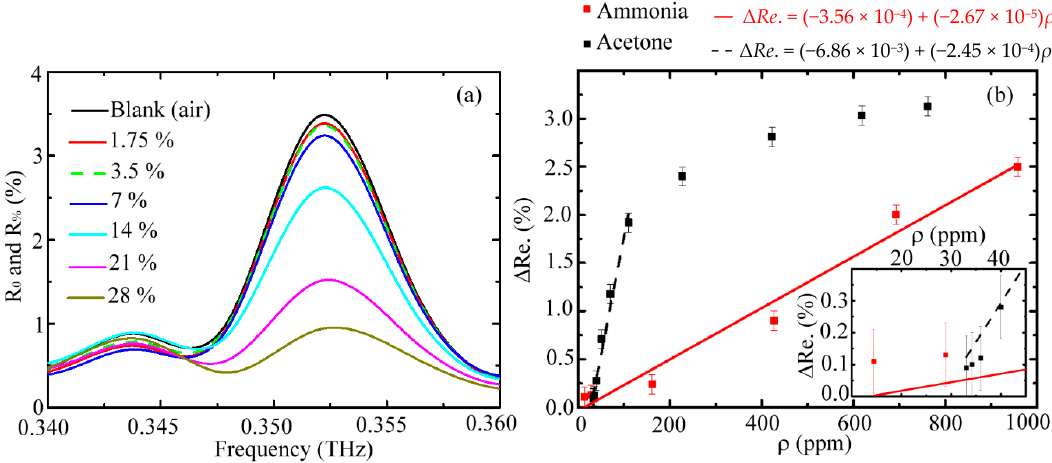
Figure 5. ( a ) Reflectivity spectra of a WGS unit for blank condition ( R 0 ) and loading various concentrations of ammonia aqueous solutions ( R % ). ( b ) Δ Re. response at 0.352 THz for acetone and ammonia vapors with different ρ values. (Insertion) Δ Re. response of 0.352 THz for ρ values less than 45 ppm of acetone and ammonia